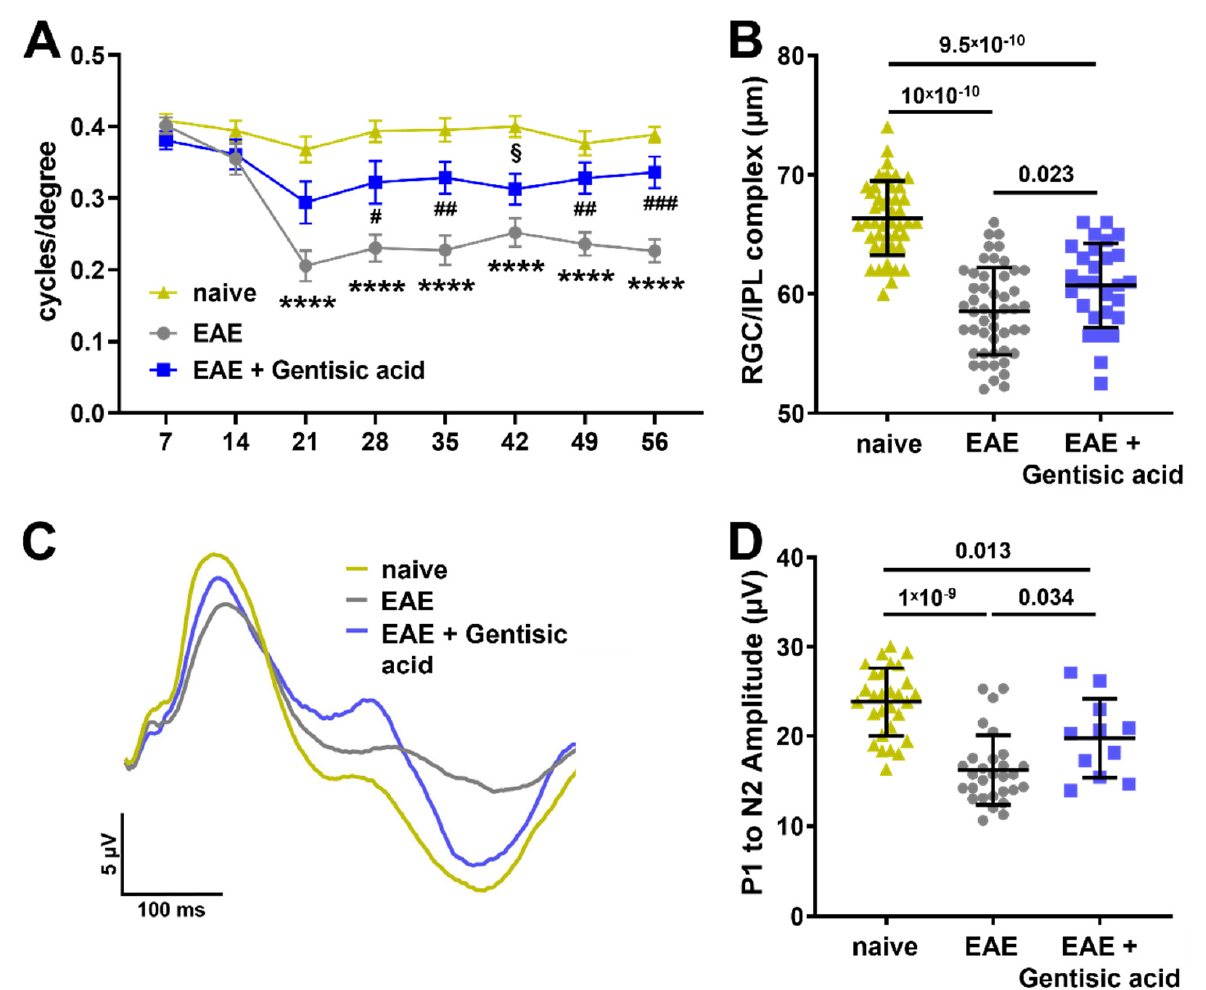
Figure 4. Gentisic acid (GA) treatment in EAE animals improves visual function and structure: ( A ) assessment of visual acuity over time demonstrates a significant decrease in both untreated EAE mice and GA-treated EAE animals as of 21 days after EAE induction. More importantly, EAE mice in the GA treatment cohort show a solid preservation in visual acuity thereafter with a trend towards recovery. Mean data are given with SEM, **** p < 0.0001 in EAE vs. naïve, # p < 0.05, ## p < 0.01, ### p < 0.001 in EAE vs. EAE + GA, and § p < 0.05 in EAE + GA vs. naïve. ( B ) Analysis of the GCL/IPL complex using OCT indicates a significant decrease in thickness in untreated EAE mice whereas GA treatment significantly ameliorates GCL/IPL complex thinning. ( C ) Cumulative pattern ERG tracing results from each group demonstrate a clear reduction in the amplitudes in untreated EAE mice and a preserved pattern ERG waveform in EAE animals having received GA. ( D ) The P1-N2 amplitude in EAE mice is significantly reduced when compared to GA-treated EAE animals as well as naïve mice. Data shown in ( B ) and ( D ) represent individual eyes with mean ± SD. Since cholesterol is necessary for maintaining normal retinal structure and function, we examined structural changes in the retinas of all the EAE mice, specifically within the GCL/IPL complex, using OCT. As anticipated, the untreated EAE animals had a significant thinning of the GCL/IPL complex compared to the naïve controls (EAE: 59 ± 4 µ m vs. naive: 66 ± 4 µ m, p = 10 × 10 − 10 ). The GA treatment in the EAE animals significantly lessened GCL/IPL complex thinning compared to the untreated EAE animals (EAE: 59 ± 4 µ m vs. EAE + GA: 61 ± 4 µ m p = 0.023); however, the GCL/IPL complex was still significantly thinner than naïve controls ( p = 9.5 × 10 − 10 , Figure